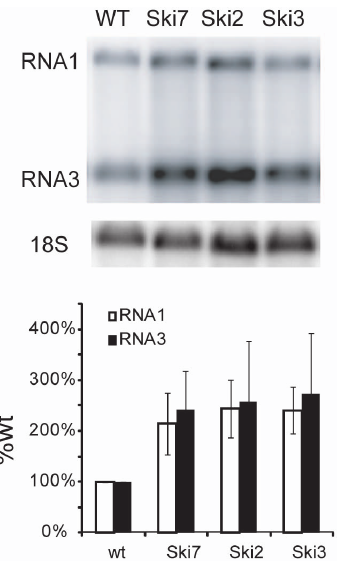
Figure 4. Genes in the Ski pathway normally suppress FHV replication in yeast. Yeast strains with the indicated Ski gene deletions were transformed with plasmid pF1 (Figure 1A) and, following galactose-induction of pF1 transcription, FHV genomic RNA1 replication and subgenomic RNA3 production were assayed by Northern blot hybridization. The histograms show the averages and standard deviations of RNA1 and RNA3 levels across four independent experiments. Representative Northern blots are shown above the histograms.